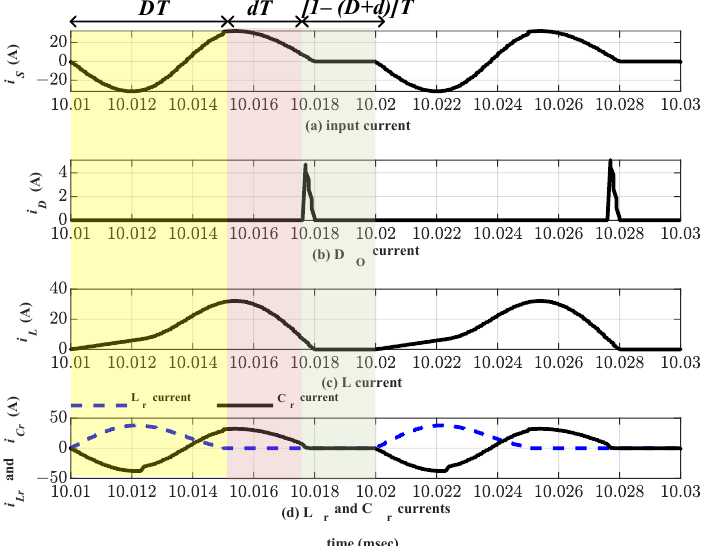
Figure 7. Soft-switching operation of the converter switches in simulation.